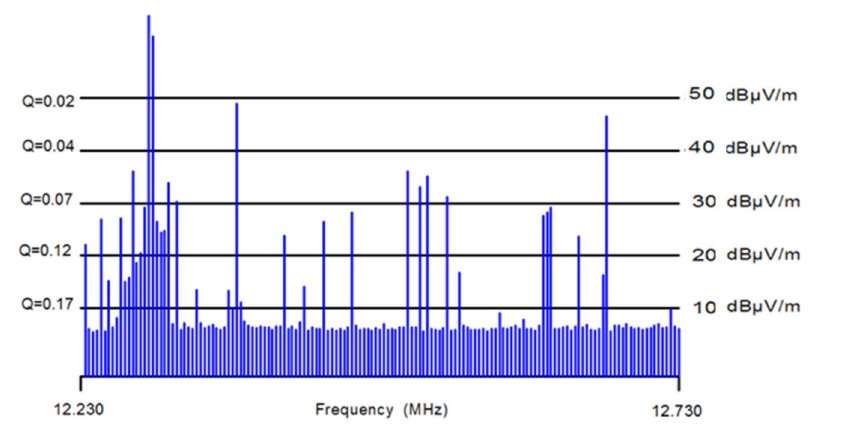
Figure 1. ( a ) Measurement system; ( b ) HE016 antenna.